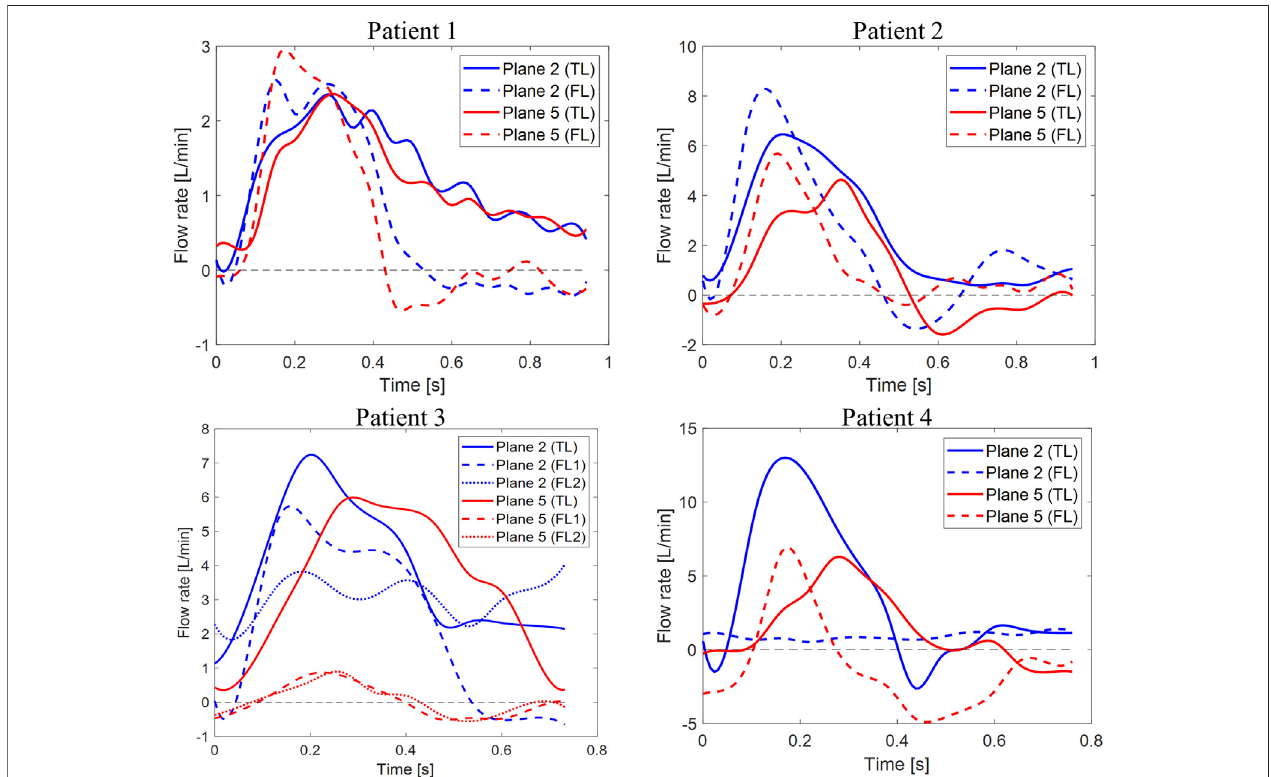
FIGURE4| Flowratewaveforms.Timeplotsof fl owratescalculatedthroughplanestwoand fi veintheTLandFLforthefourpatients. Y -axislimitswereadjustedto better show each patient ’ s waveforms.